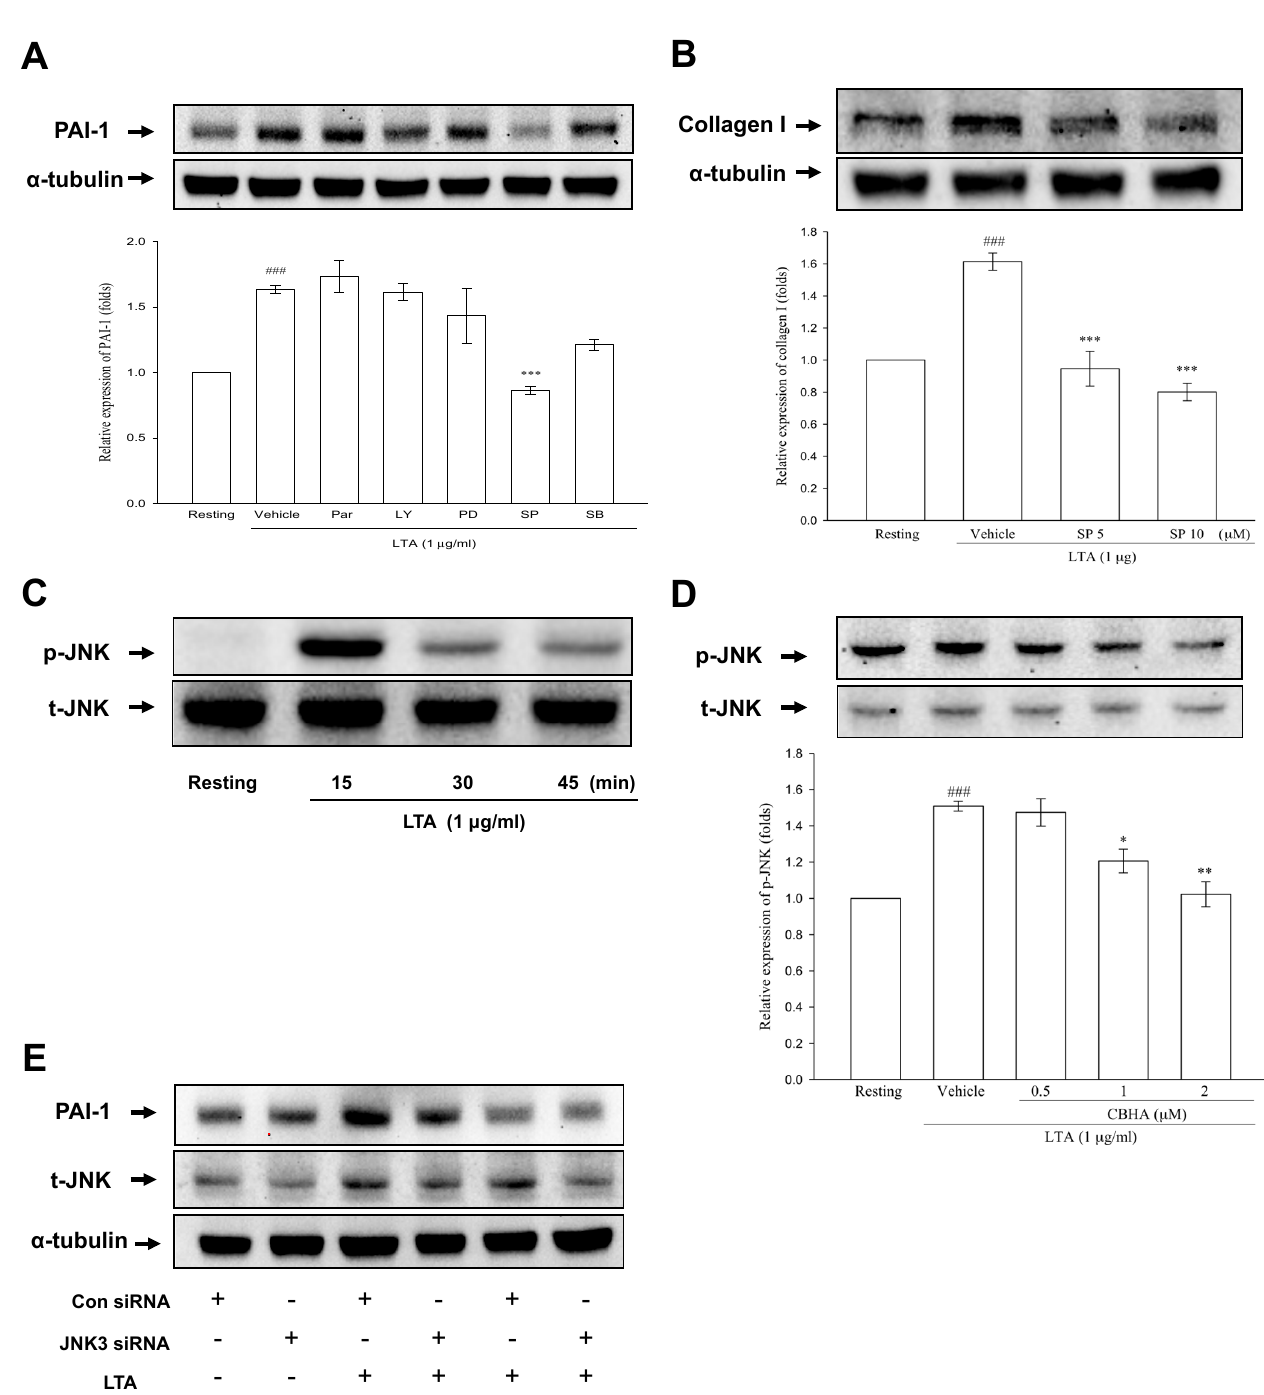
Figure 3. CBHA blocks LTA-induced JNK phosphorylation in human PMCs. ( A ) MeT-5A cells were treated with vehicle or various signal pathway inhibitors inclusive of parthenolide (Par, 10 µ M), LY294002 (LY, 20 µ M), PD98059 (PD, 20 µ M), SB203580 (SB, 10 µ M) and SP600125 (SP, 10 µ M), respectively, then stimulated with LTA for 24 h. PAI-1 expression was analyzed by western blot and measured by optical densitometry analysis. Data were pooled from three independent experiments and expressed as average fold change (mean ± SEM) in the expression relative to resting or vehicle group. ( B ) MeT-5A cells pretreated with vehicle or SP600125 (SP, 5-10 µ M) were stimulated with LTA for 24 h. Collagen I expression was analyzed by western blot and measured by optical densitometry analysis. Data were pooled from three